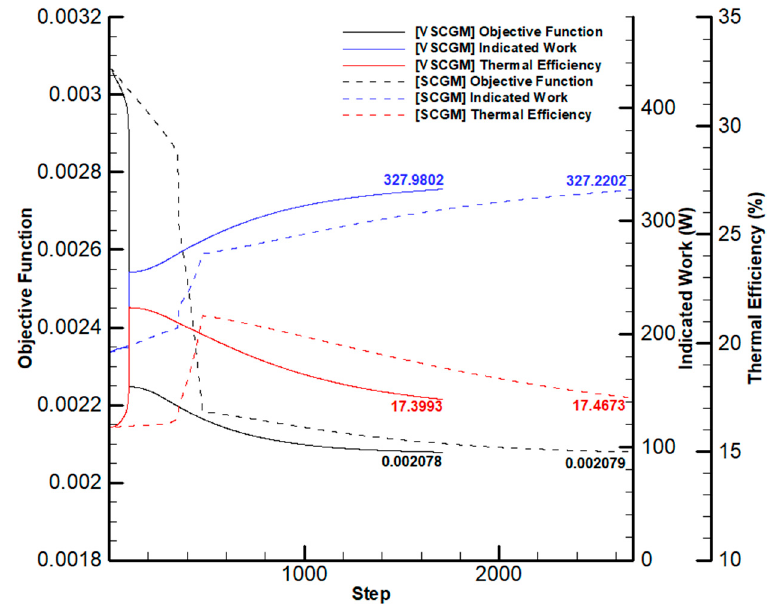
Figure 8. Comparison between VSCGM and SCGM.